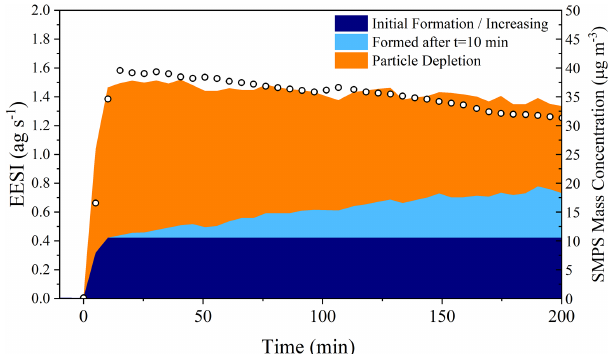
Figure 7. The left axis shows the total EESI-ToF intensity plotted as a function of the contribution from different sources, particle-phase formation products determined from those molecular formulae that increase during dark aging after t = 10min from Exp. 2. The right axis shows the measured SMPS mass concentration. Both the EESI and SMPS have been for wall